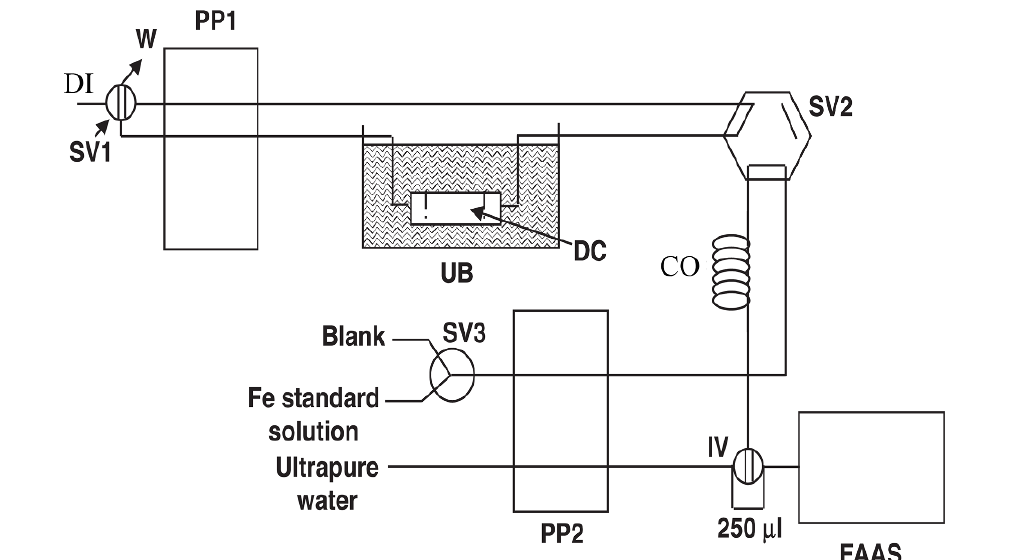
Figure 5. Schematic presentations for (A) continuous USAD coupled with FAAS; CO: coil, DI: digestant, DC: digestion chamber, IV: injection valve, PP: peristaltic pump, SV: switching valve, UB: ultrasonic bath and W: waste (reproduced with permission of Elsevier-modified [